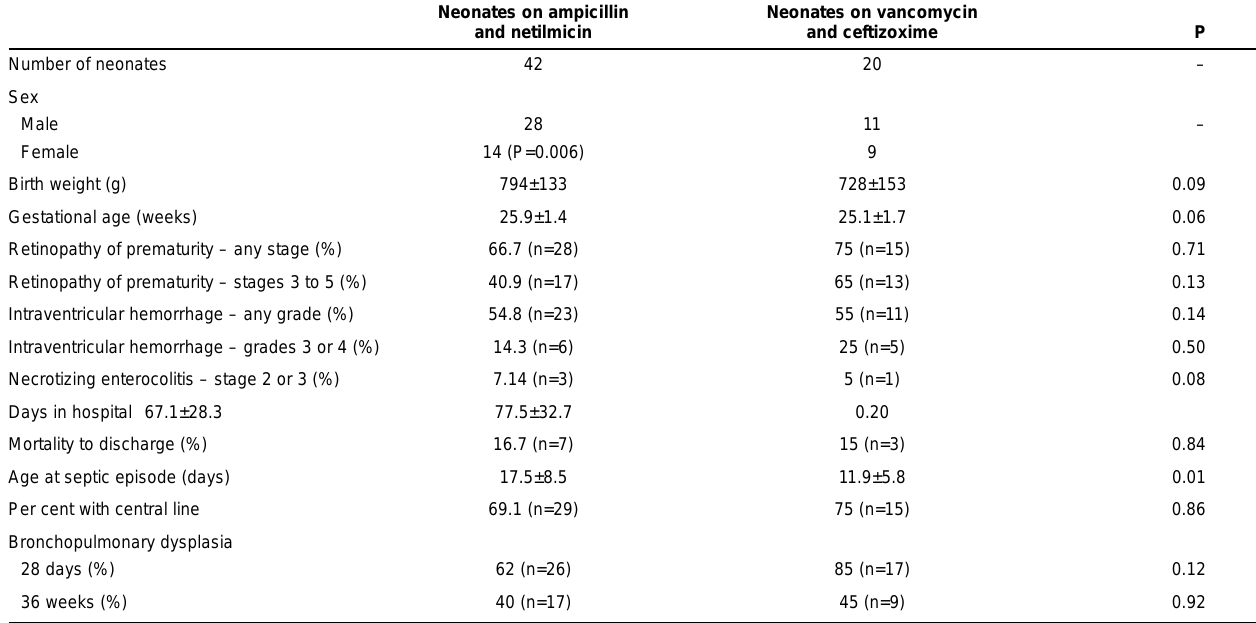
TABLE 1 Characteristics of patients